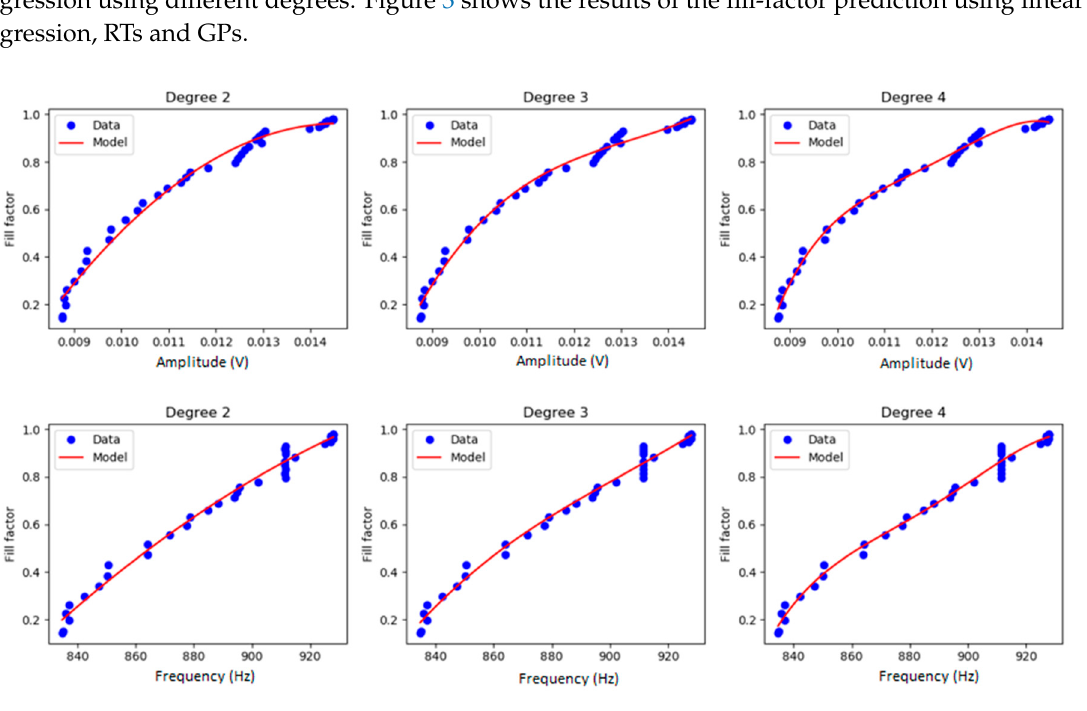
Figure 2. Polynomial regression of the fill-factor against frequency (Hz) and amplitude (volts) for N2A. Di ff erent degrees (2, 3, and 4) were used for the polynomial regression, for predicting the fill-factor of the cell culture from the amplitude (volts) and frequency data